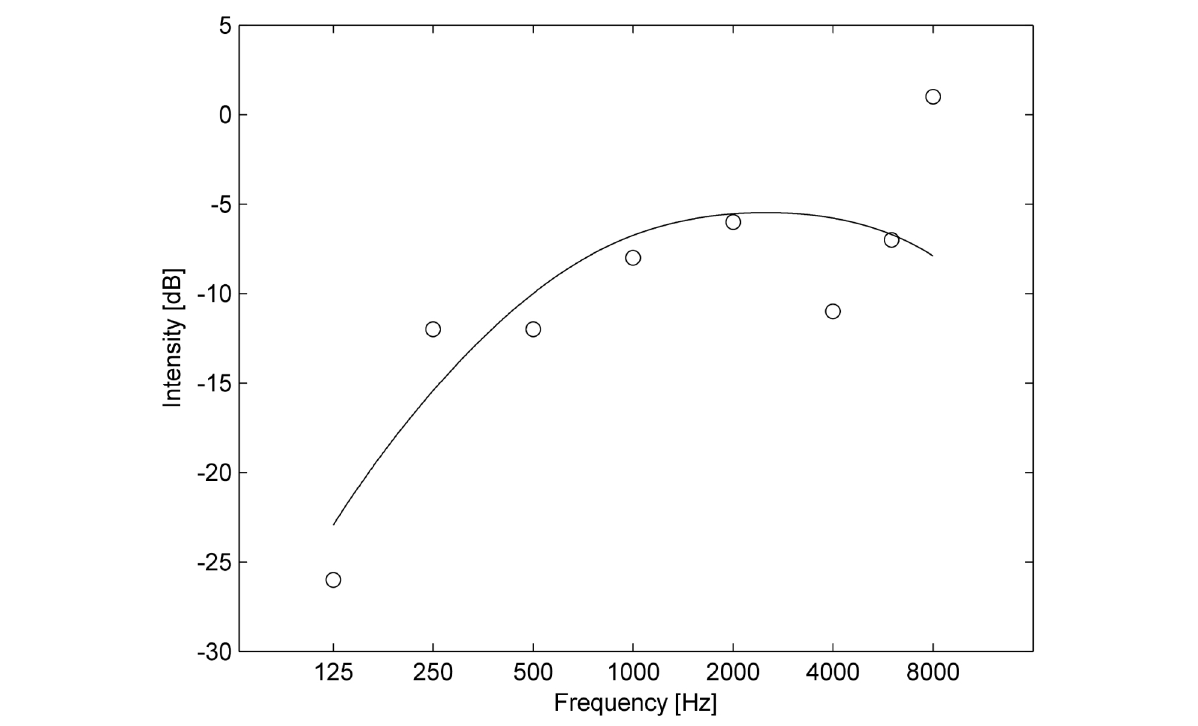
(Table 1) divided by a square root of 2, the standard deviation of the real bilateral hearing threshold can be calculated from equation 11 (Table